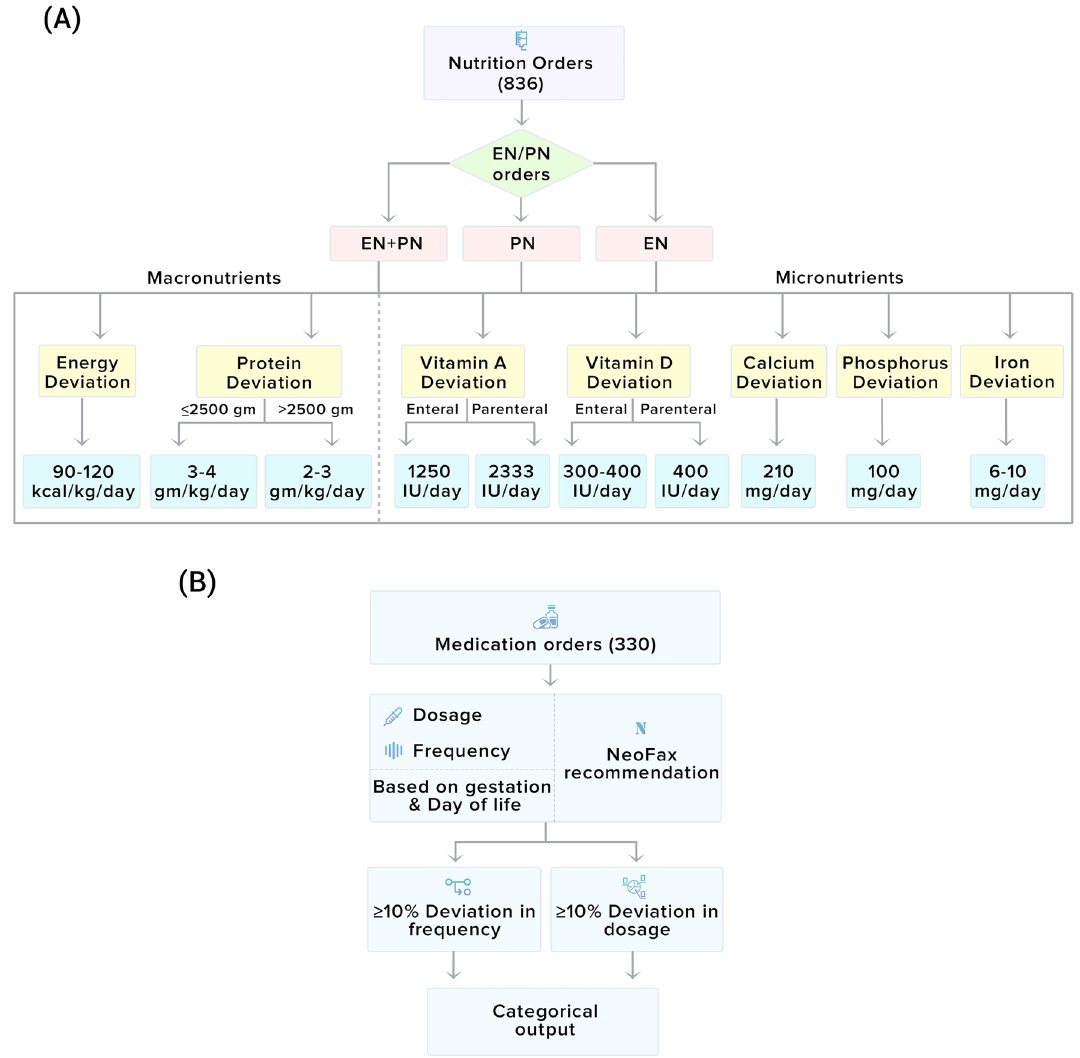
Figure 3. ( A ) Nutrition recommendation for neonates as per ASPEN guidelines. ( B ) Medication deviation reference and calculation